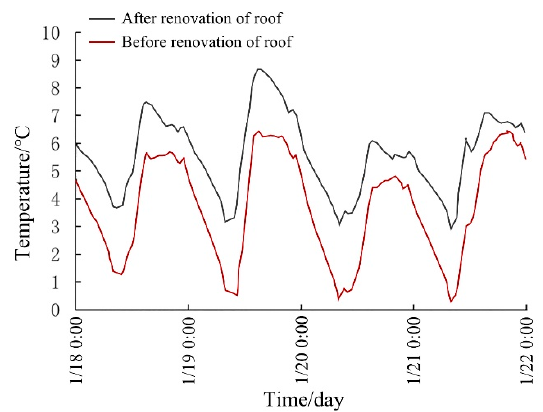
Figure 16. The simulated temperature of the master bedroom before and after renovation of the roof.